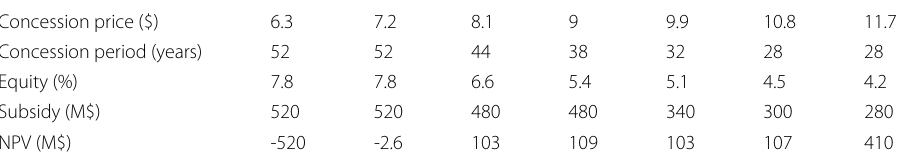
Table 5 Effects of changing the concession price on the other concession parameters Concession price